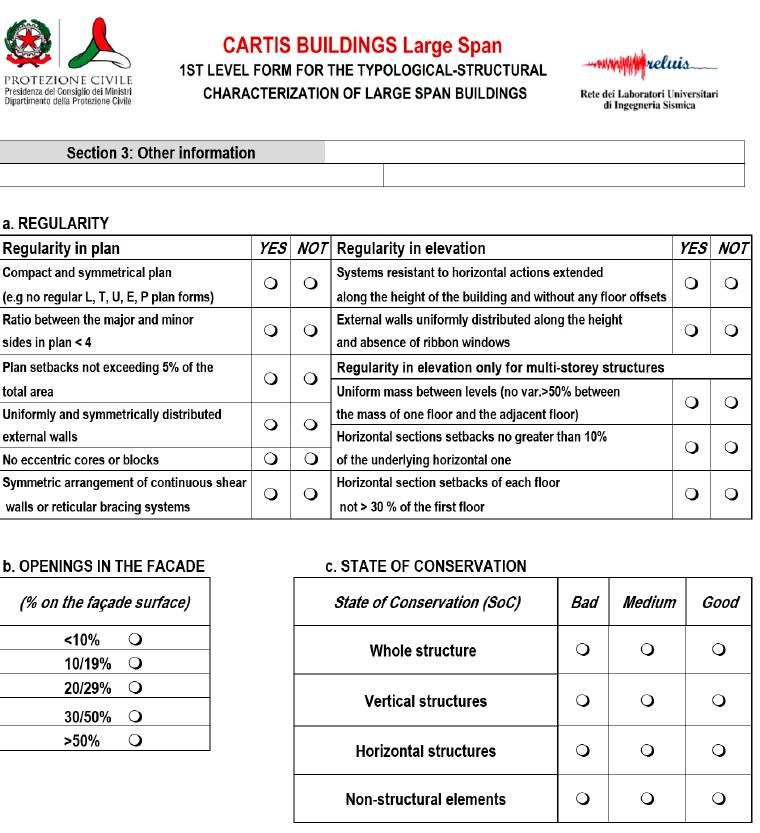
Figure 25. Section 3 CARTIS-Building: Other information (English version [19]).